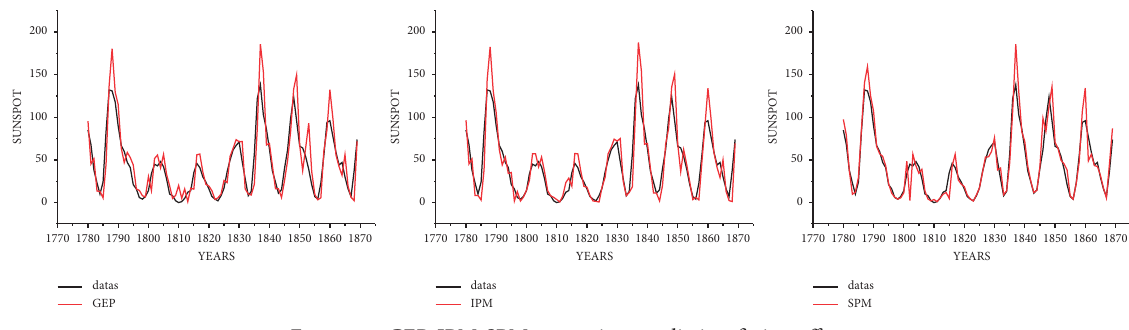
Figure 7: GEP-IPM-SPM regression prediction fitting effect.